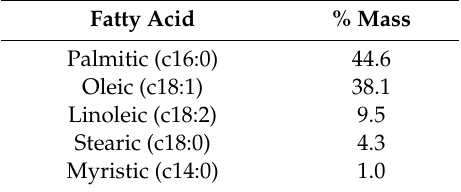
Table 1. Fatty acid composition of palm oil used in this